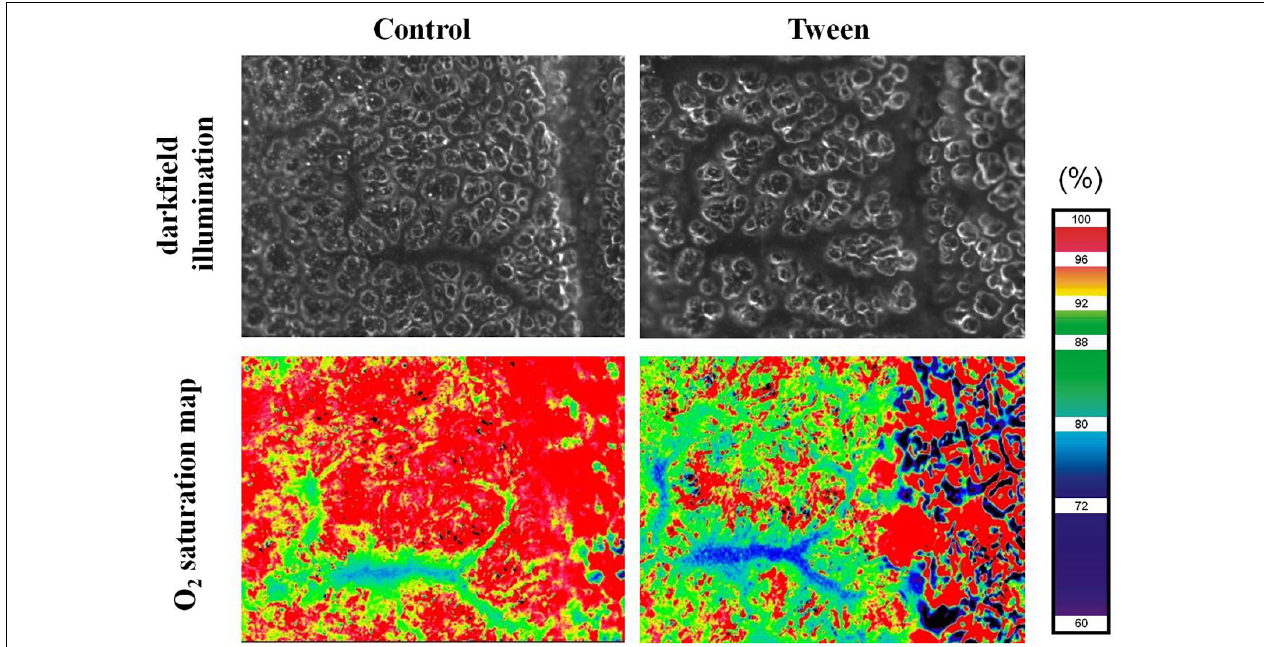
FIGURE 3 | Oxygen saturation map. Representative images of a pulmonary arteriolar vessel tree in a ventilated mouse with the surrounding alveolar capillary network under control conditions and after treatment with tween imaged by darkfield microscopy (top) and multi-spectral oximetry resulting in the generation of a corresponding oxygen saturation map (bottom). Note impaired alveolar structure and oxygenation in the Tween model of acute lung injury. Ethical approval for the animal experiment was obtained from the Animal Care Committee of St. Michael’s Hospital